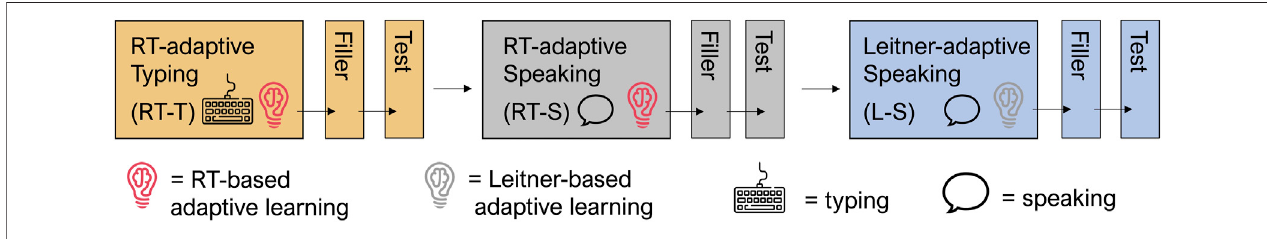
FIGURE 2 | Experimental